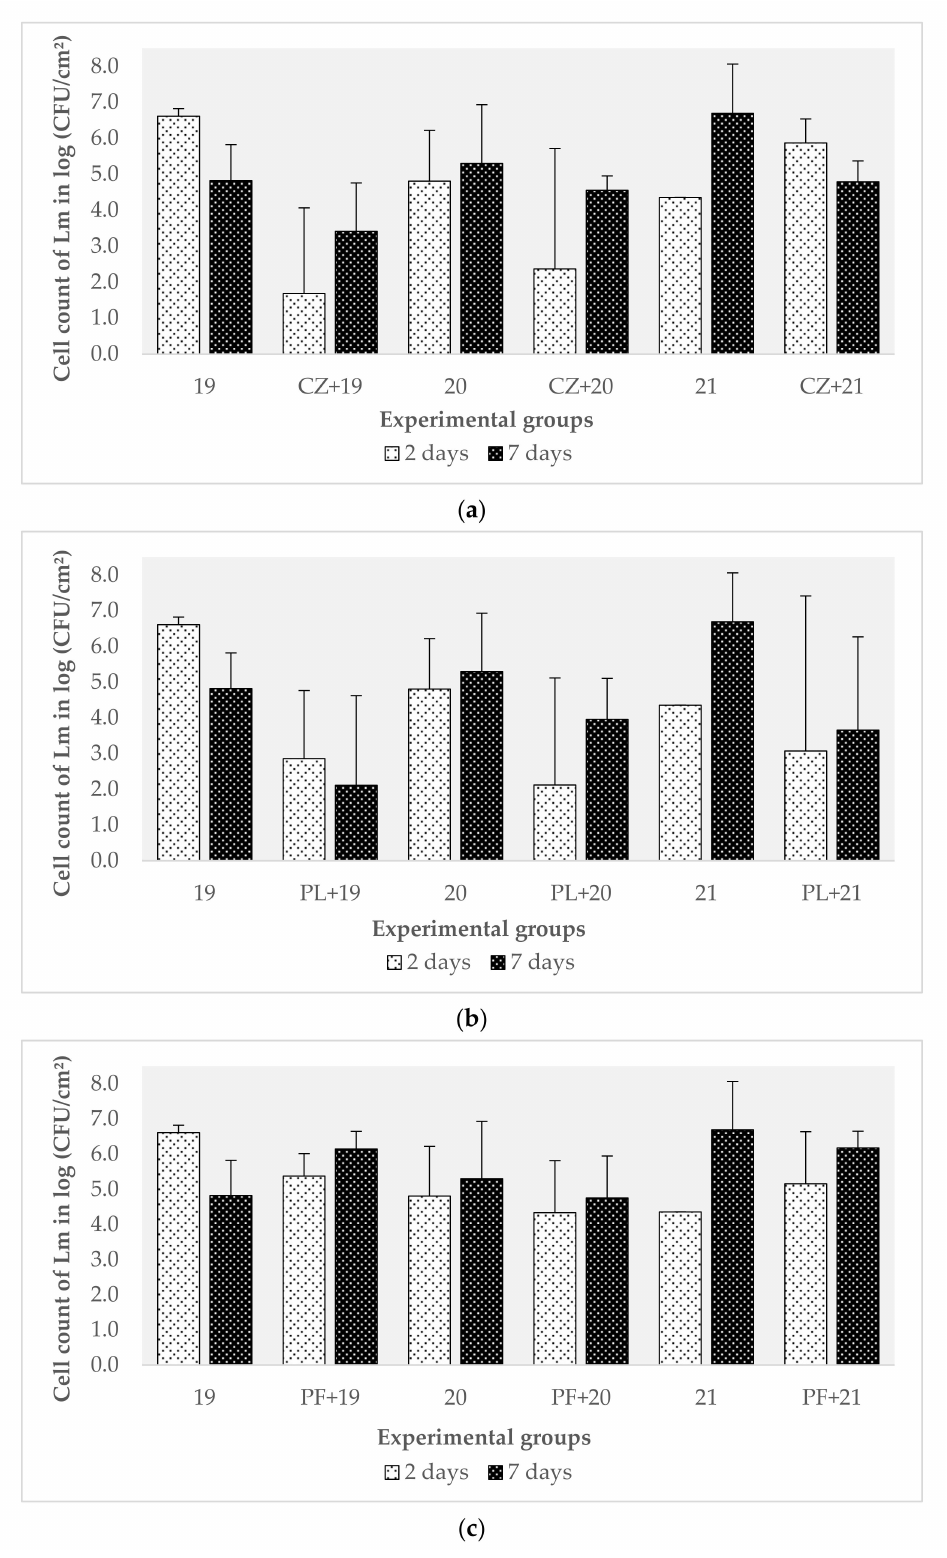
Figure 3. Counts on ALOA agar of Listeria monocytogenes strains from monospecies biofilm controls (Lm 19, 20, 21) and mixed biofilms with: ( a ) Candida zeylanoides ; ( b ) Pseudomonas luteola ; and ( c ) Pseu- domonas fluorescens, at two and seven days of incubation. The error bars represent the standard error of the mean (n =